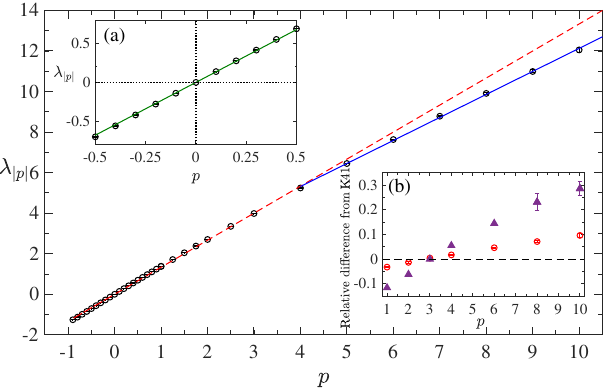
FIG. 7. Scaling exponents as a function of moment order p ; R ¼ 1300 . The data can be fitted by two separate lines, one λ below order 3 and one above it. For comparison purposes, the dashed line is the K41 result given by 4 p= 3 . The low-order data can be fitted best by the expression λ j p j ¼ ð 1 . 367 (cid:2) 0 . 0095 Þ p with no intercept as shown in inset (a) by the solid line. The high- order data can be fitted (solid line) by a monofractal model, λ ¼ 1 . 1 p þ ð 3 − D Þ , with D ¼ 2 . 2 . Both fits are determined by j p j least-squares method. The error bar shown for the tenth moment is typical and is subsumed by the symbol thickness. Inset (b) compares the relative departures of circulation exponents at R ¼ 1300 and longitudinal velocity increment exponents (filled λ triangle) at R λ ¼ 10340 [26], from their respective K41 estimates, for integral orders. The dashed line at zero is the K41 scaling. The relative deviations from K41 for higher-order circulation expo- nents are about a third of those of the longitudinal structure function exponents (but the sign of these differences in both cases is the